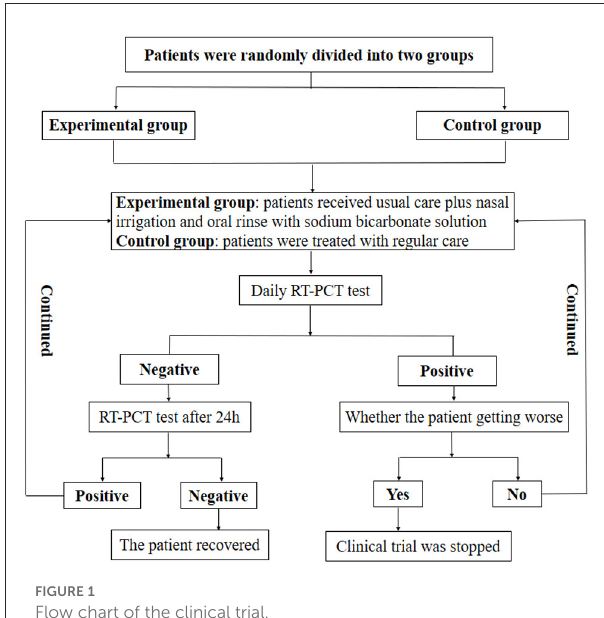
FIGURE1 Flow chart of the clinical